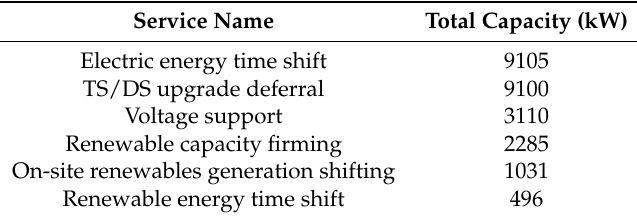
Table 2. Total capacity of the most widely deployed ancillary services in the